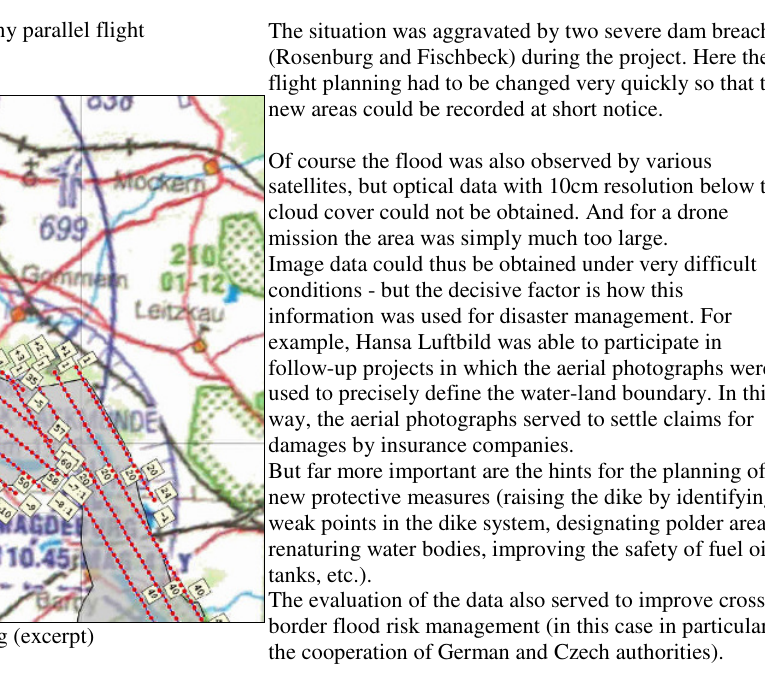
Fig 5: Project area Elbe, Saale and